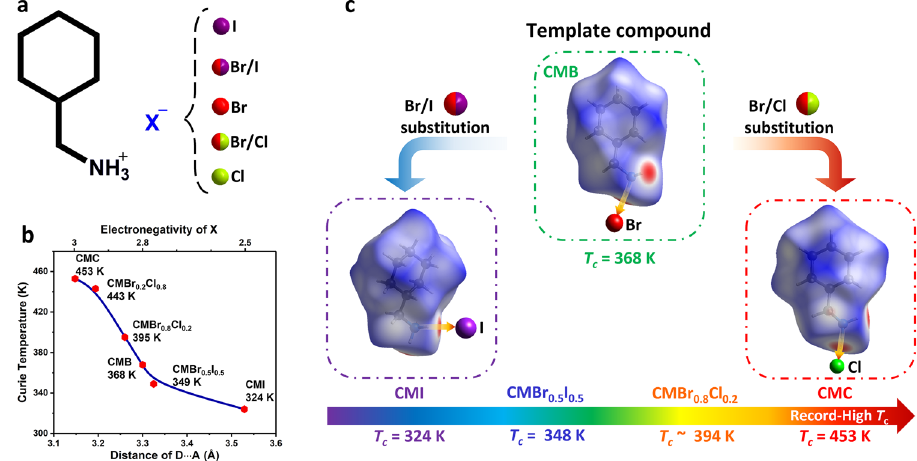
Fig. 1| Diagramforthemolecule-leveldesignofmetal-freemolecularAFEsina seriesofCMBrxI 1 − x andCMBrxCl 1 − x (0 ≤ x ≤ 1)solidsolutions.a Basic structures for solid solutions. b The relationship between Curie temperatures and D···A distances of hydrogen bonds, where donor (D) is N of organic CM + cation and acceptor (A) is halogen (X). The D···A distances can be obtained from the